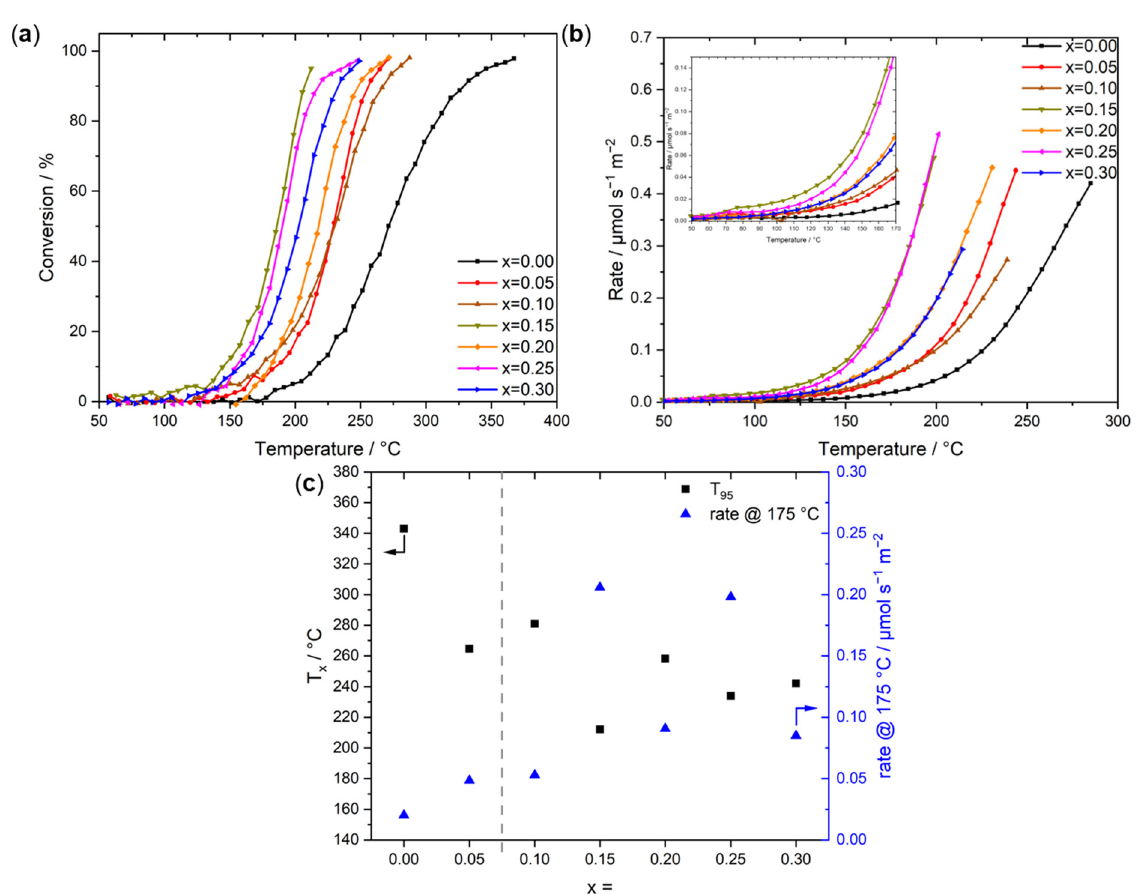
Figure 5. ( a ) CO oxidation conversions of the perovskites from 50 to 500 °C in the reaction mixture of 2% CO + 20% O 2 balanced in He. ( b ) Rates of the sample series up to a conversion of 65% in the same reaction mixture. ( c ) Comparison between CO oxidation conversions for 95% conversion and rates at 175 °C derived from ( a , b ).